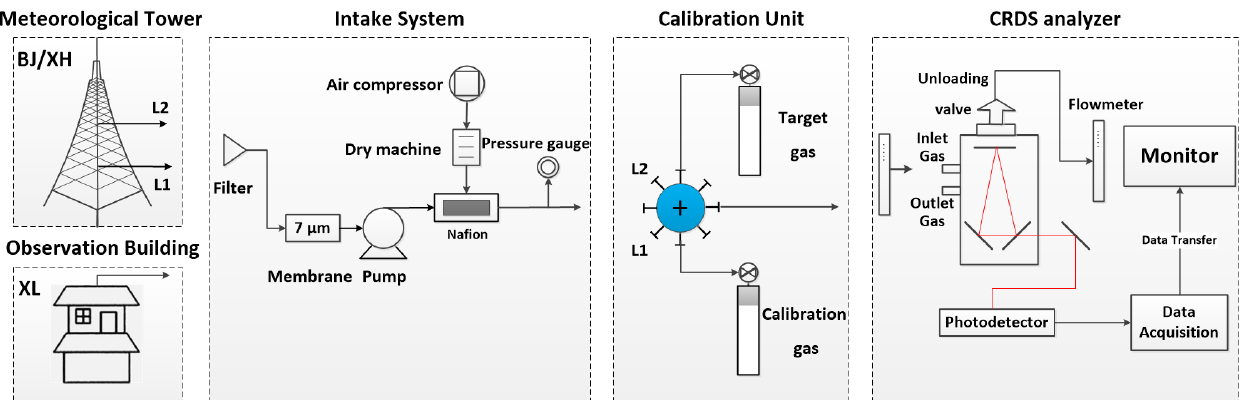
Figure 2. Schematic diagram of the measurement system, including a meteorological tower at BJ/XH or observation building at XL, an intake system, a calibration unit, and a CRDS